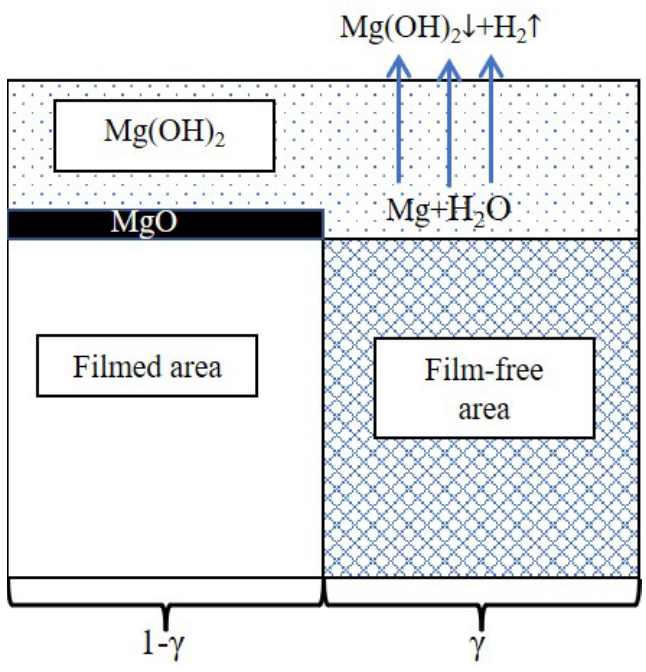
Figure 12. Schematic diagram of the surface film.